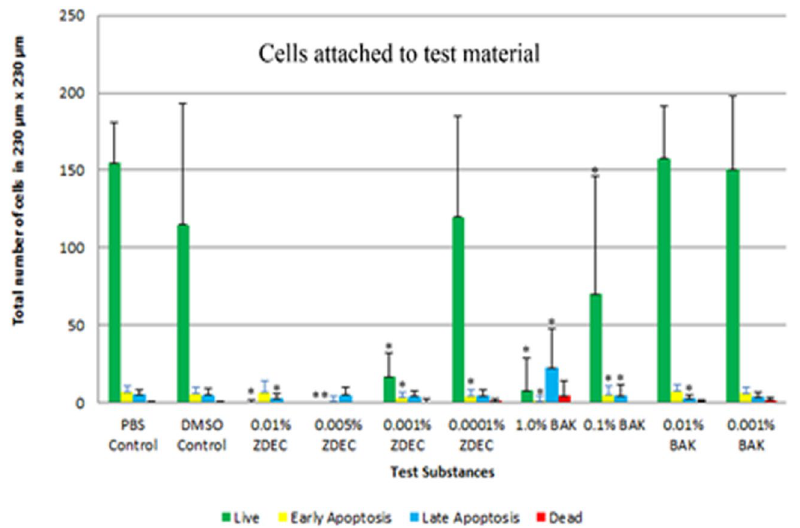
Figure 3. Viability of adhered HLEC to treated silicone surfaces in an area of 230 μm × 230 μm. Viability was quantified by counting the number of live, early and late apoptotic, and dead cells displayed as the first, second, third, and fourth bar of each test substance respectively. n = 15 in each of two separate experiments. *p < 0.05 of the PBS control. Error bars are the standard